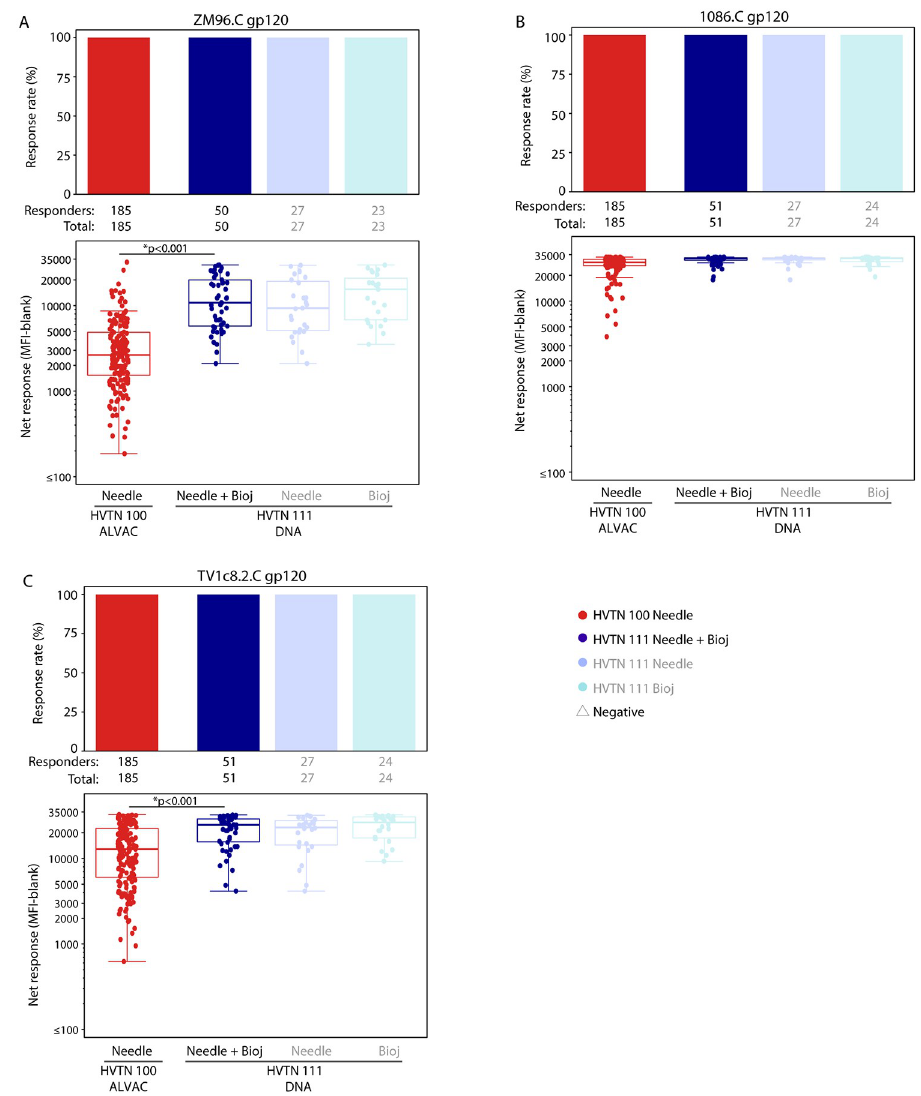
Fig 2. IgG bAb responses to gp120 vaccine-matched antigens at 1:200 dilution among per-protocol vaccine recipients of HVTN 100 and HVTN 111. (A) ZM96.C gp120, (B) 1086.C gp120, and (C) TV1c8.2.C gp120. Bar charts show the observed, unadjusted positive response rates. Boxplots show observed responses and are based on positive responders only (shown as colored circles). � TMLE p -values reported; Wilcoxon p -values also < 0.001. HVTN 100 is compared only to the combined arms of HVTN 111 (shown in dark blue) as no differences were seen between the needle and Biojector arms of HVTN 111 (shown in pale blues). bAb, binding antibody; HVTN, HIV Vaccine Trials Network; MFI, mean fluorescence intensity; TMLE, targeted minimum loss